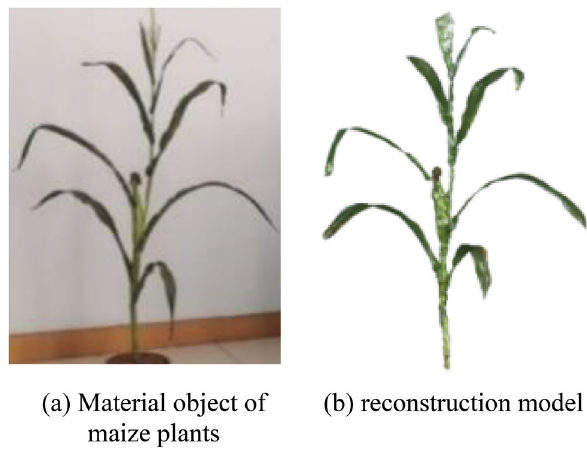
Figure 14. 3D reconstruction results of maize plants.